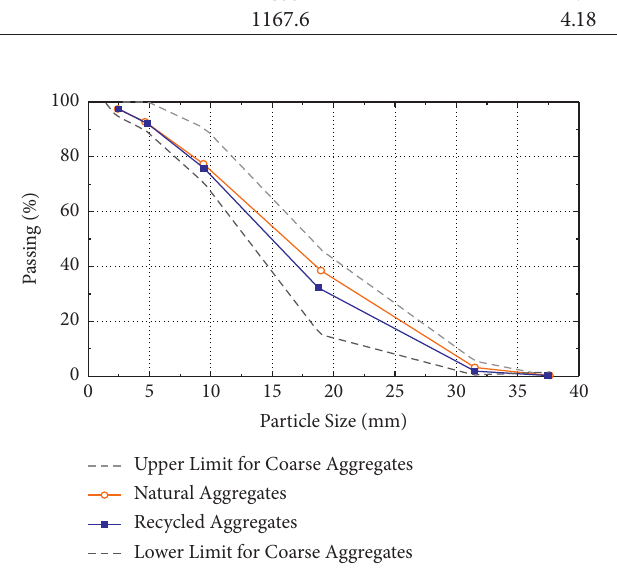
Figure 1: Coarse aggregates gradating curves.